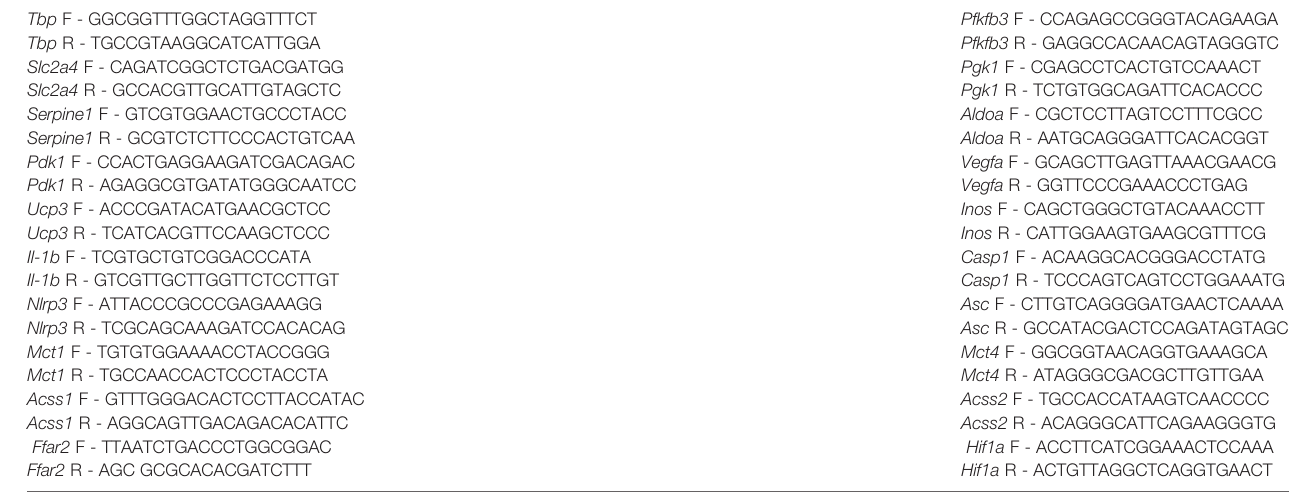
TABLE 1 | Primer sequences used for